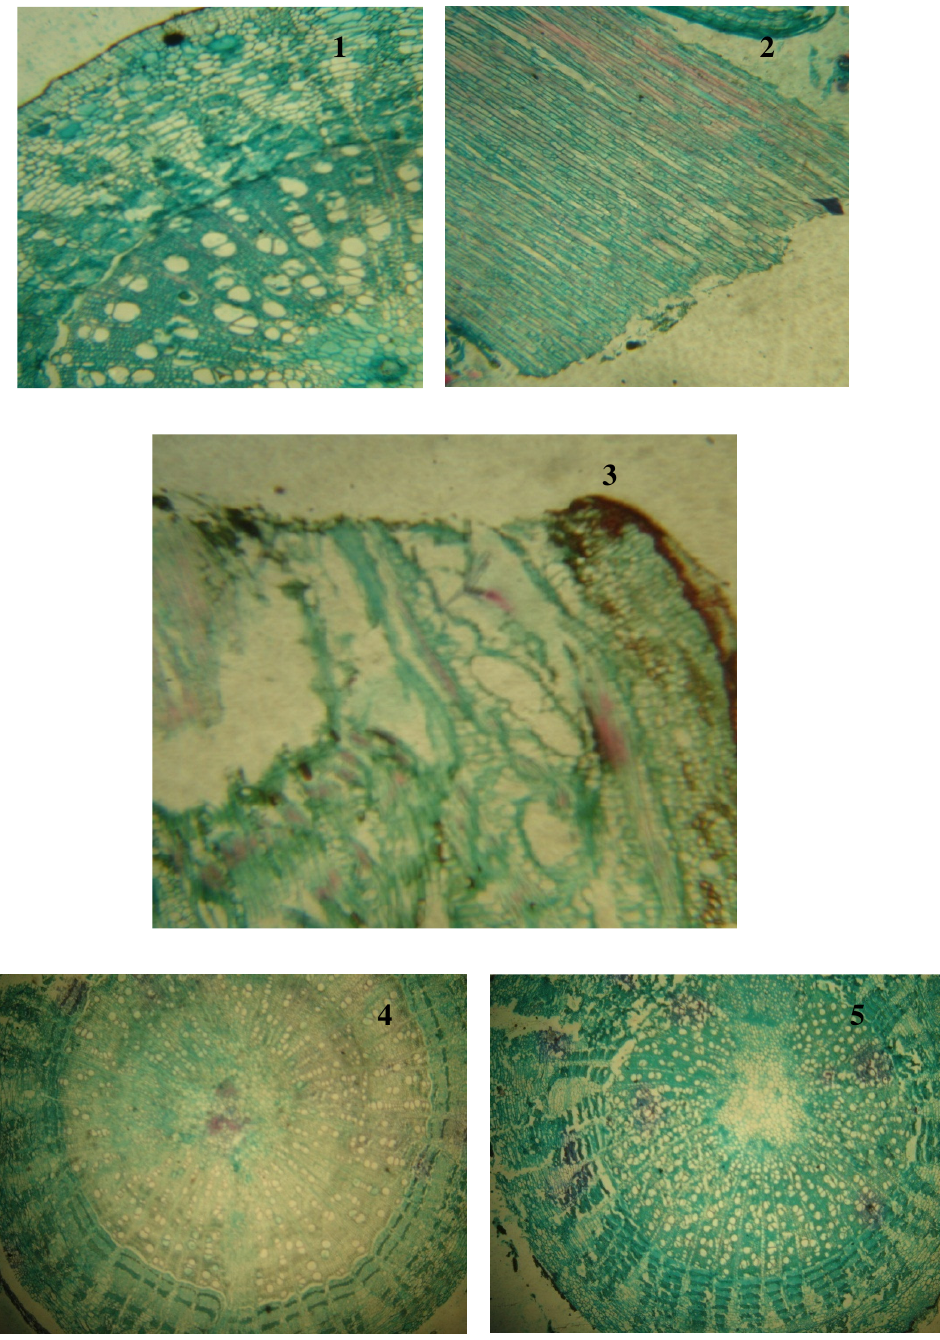
Fig . 1. The transverse section of the anatomical feature of Cleistopholis patens . Fig. 2. The longitudinal section of anatomical feature of Monodora tenuifolia. Fig. 3. The transverse section of G. suaviolis with the tracheid clearly outlined while. Fig. 4. The transverse section of the anatomical feature of Annona squamosa at magnification of ×4. Fig. 5. The transverse section of the anatomical feature of A. glauca at magnification of